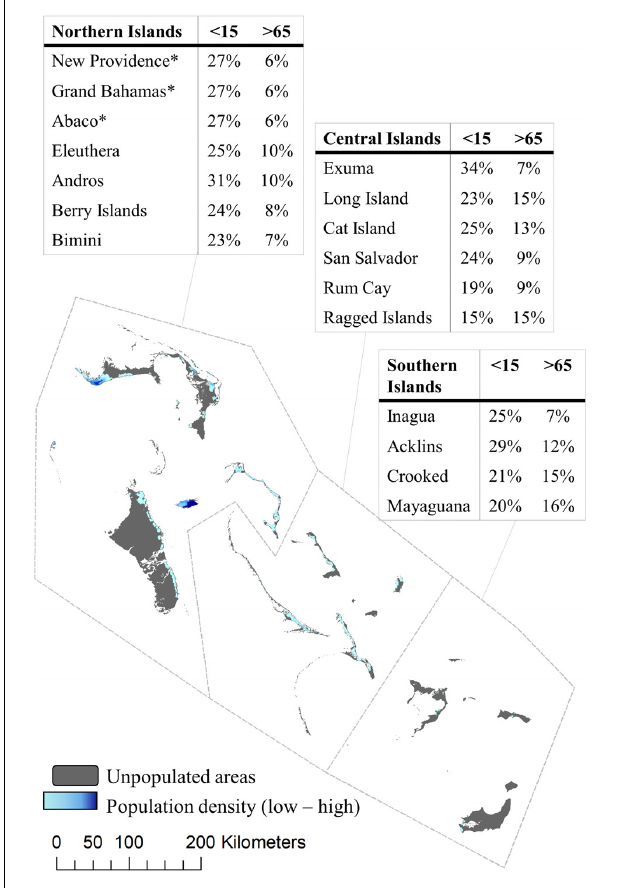
FIGURE 7 | Total population for The Bahamas, as well as elderly and young populations, were mapped using the Nighttime Lights Series (NOAA) for the 2010 population